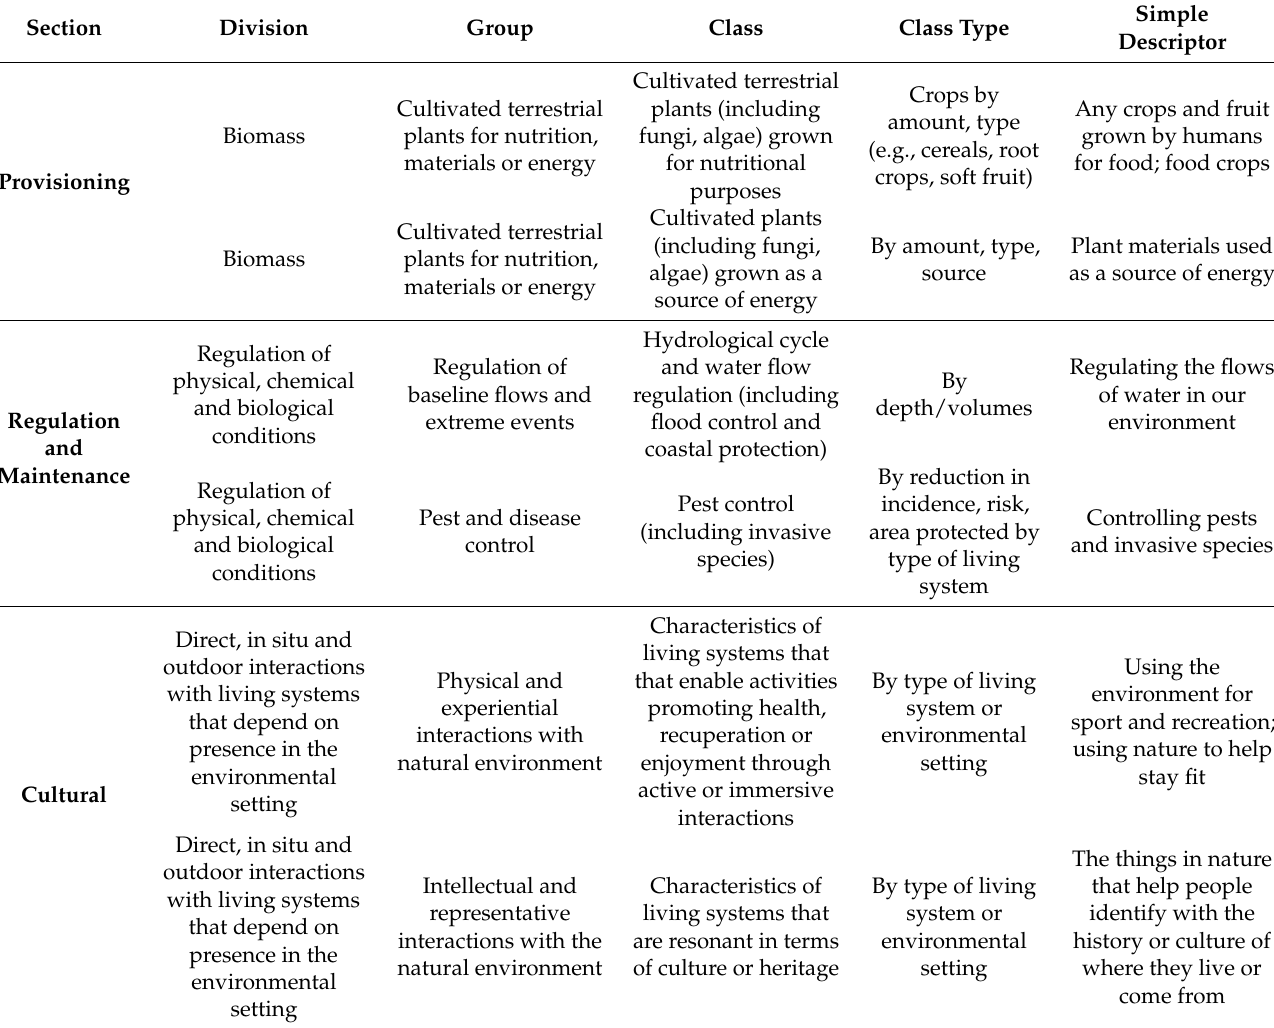
Table 1. Examples of provisioning, regulation and maintenance, and cultural ES modified according to CICES [10].